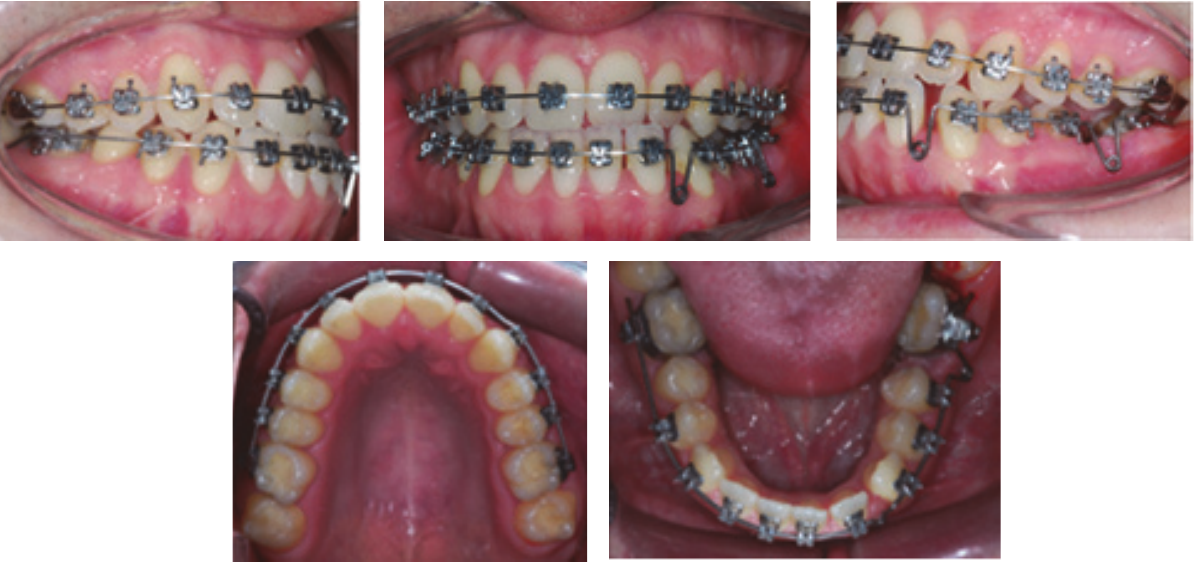
Figure 5: Intraoral views of treatment. End of leveling 0.017 󸀠󸀠 ×0.025 󸀠󸀠 stainless steel wire and retraction loops applied to close the extraction space and to correct the midline deviation.